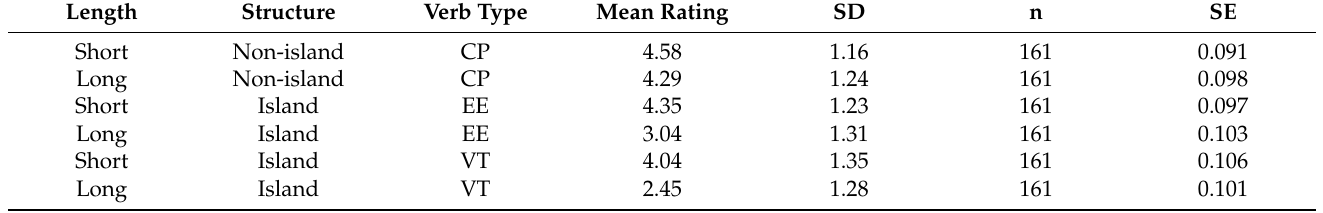
Table 6. Descriptive statistics for Experiment 3 results. Mean is calculated on raw (non-z-scored) ratings.